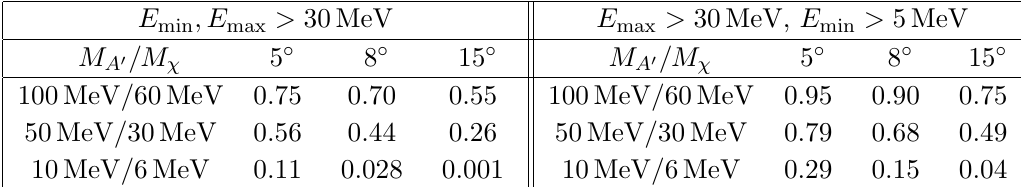
Table 2 . E(cid:14)ciencies to pass cuts on the e Monte